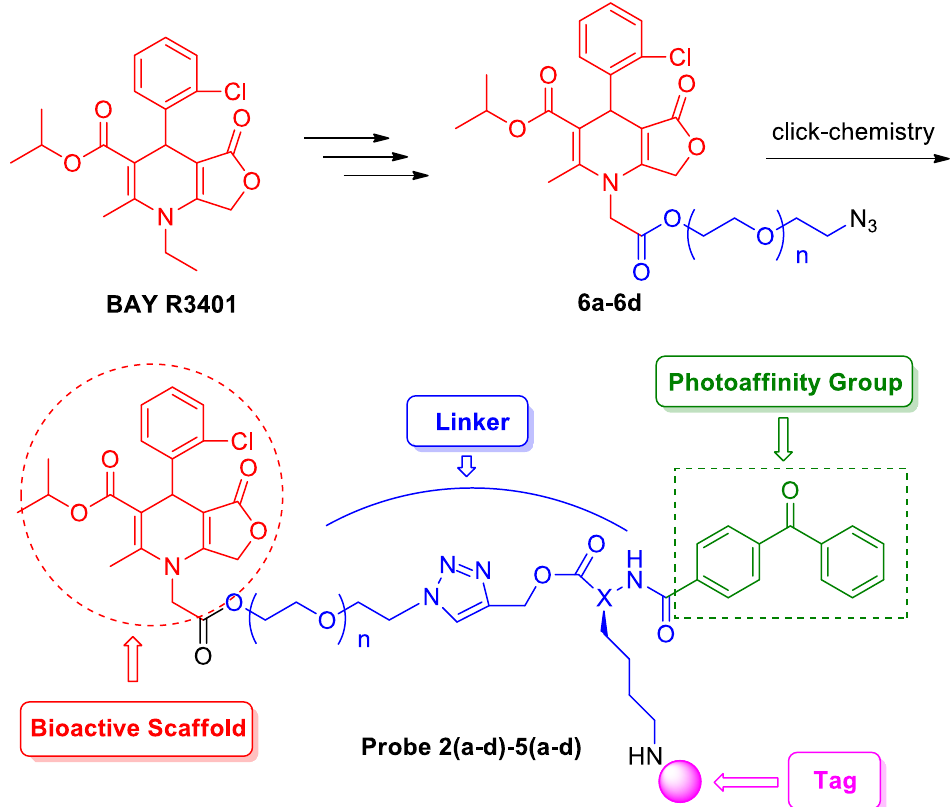
Figure 2. General synthetic strategy for photoa ffi nity probes by click-chemistry